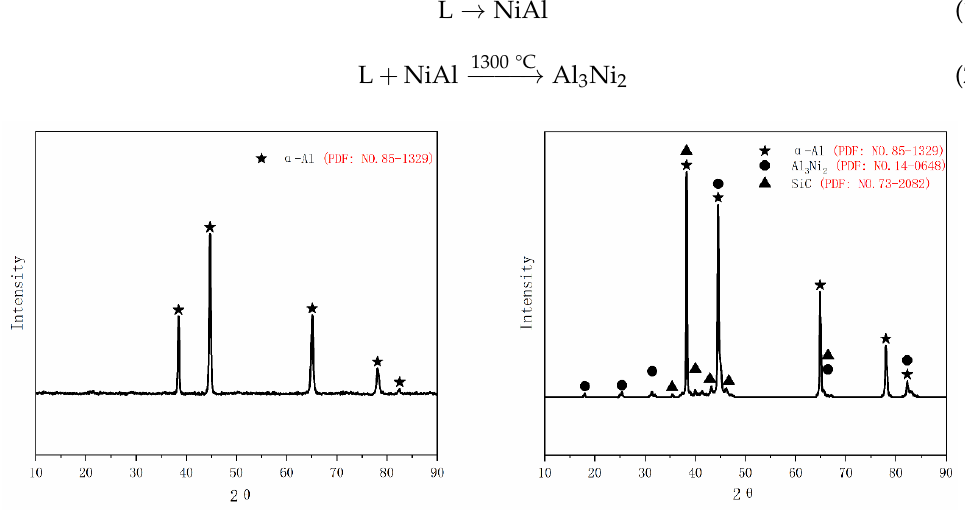
Figure 8. XRD patterns of the substrate and the biomimetic sample.